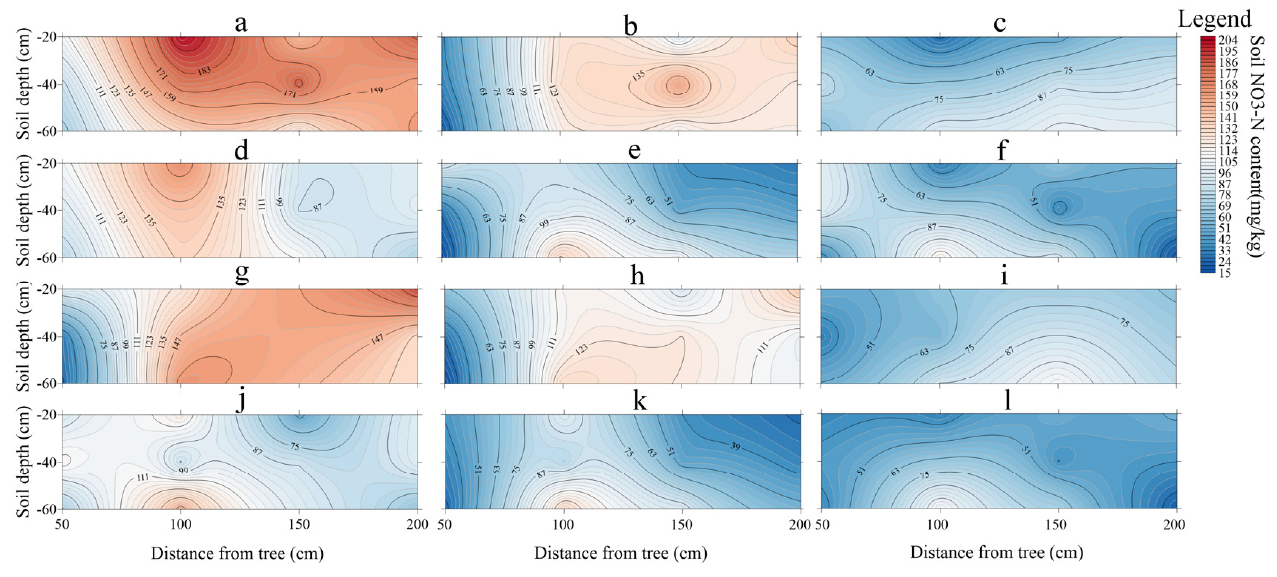
Figure 5. Two–dimensional soil NO 3 − − N content distribution in different growth stages of MA and AS systems. (left: a , d , g , j ) Soybean branching stage; ( b , e , h , k ) soybean flowering-podding stage; (right: c , f , i , l ) seed filling stage; 2020 MA ( a – c ), 2020 AS ( d – f ), 2021 MA ( g – i ), 2021 AS ( j – l ). Compared to 2020, the SNC in MA in 2021 decreased by 15.95% and 2.27% at BS and FS, respectively, with the decrease in SNC occurring mainly in T 50 and T 200 , while it increased by 4.30% at SS, with the increase in SNC occurring mainly in T 100 and T 150 . Meanwhile, the SNC in AS decreased by 11.04%, 6.14%, and 11.32%, respectively, with relatively uniform decreases across sampling